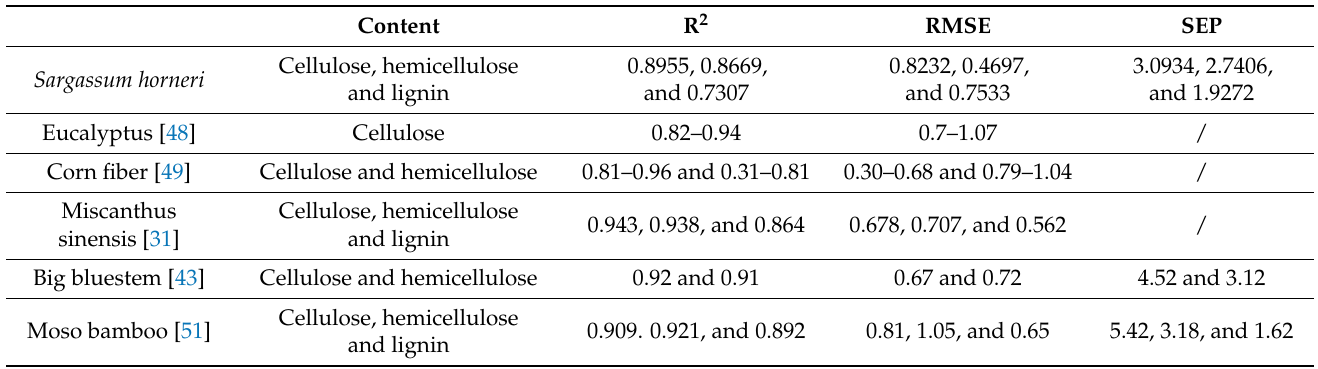
Table 5. The results of the near-infrared spectroscopy measurement of terrestrial biomass and Sargassum horneri